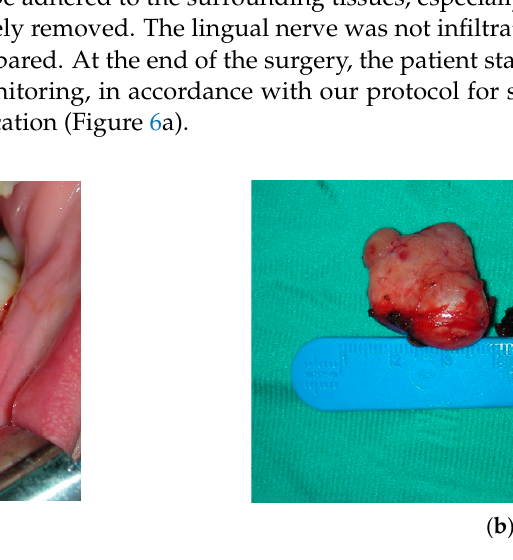
Figure 6. ( a ) Intraoperative photos of the surgical excision. ( b ) The anatomopathological